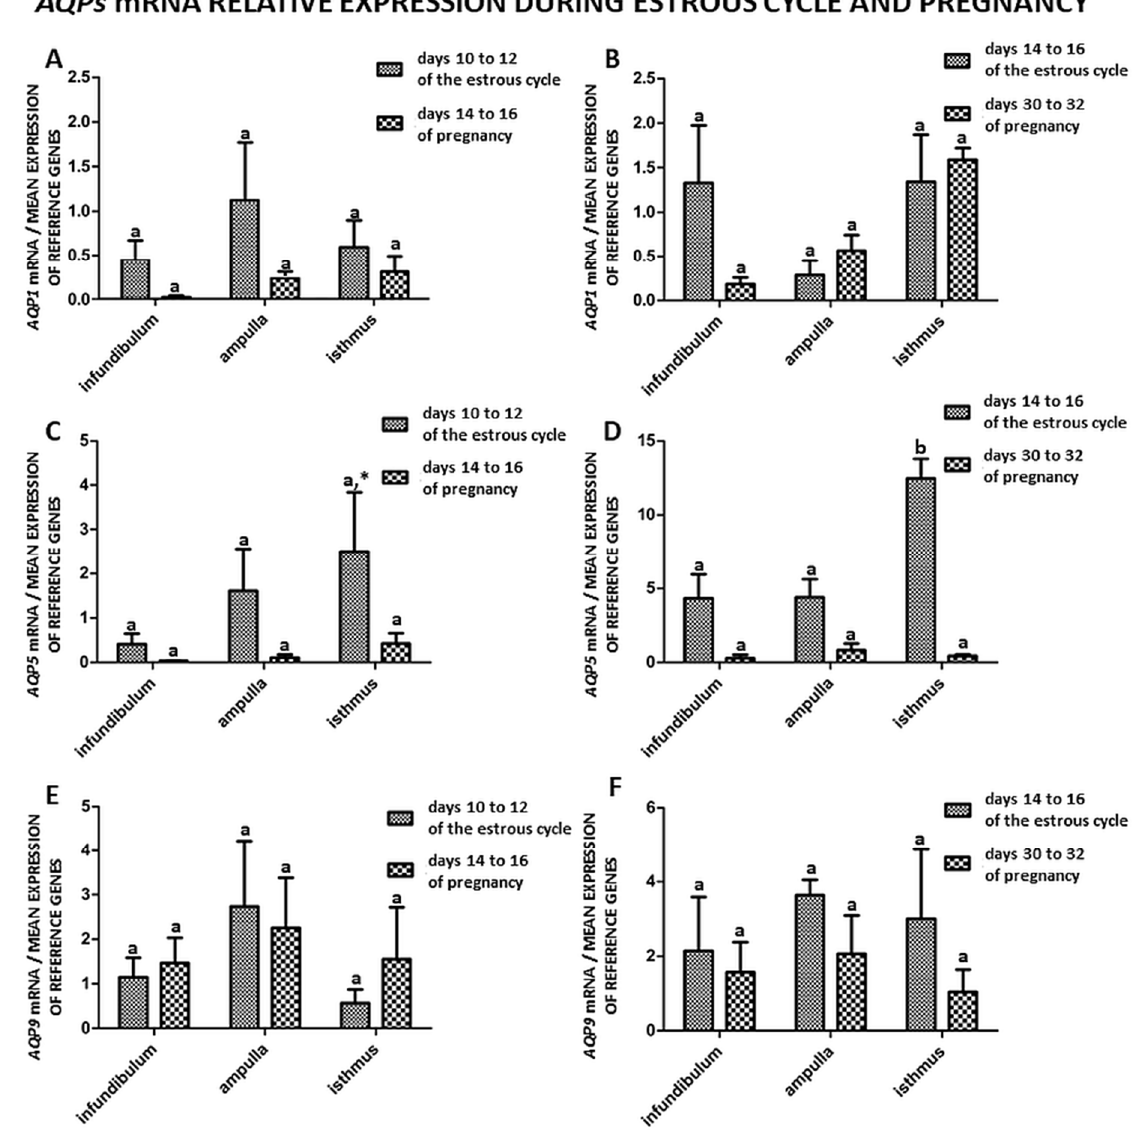
Figure 3. Comparison of the expression patterns of AQP1, 5, 9 genes in porcine oviduct separated into infundibulum, ampulla and isthmus from the estrus cycle (days 10–12 and 14–16) and early pregnancy (days 14–16 and 30–32). ( A , C , E ) summarized comparison between medium luteal phase (days 10–12) and pregnancy (days 14-16). ( B , D , F ) summarized comparison between late luteal phase (days 14–16) and pregnancy (days 30–32). The samples were subjected to qPCR analysis and normalized to the geometric mean of 18S RNA and PPIA expression. Each of the graphs marked with a capital letter indicates a specific part of the oviduct. Values are expressed as means ± S.E.M from five individuals, each performed in triplicate ( p < 0.05) ( n = 5). Statistically significant differences between the part of the oviduct from the estrous cycle and early pregnancy are indicated by different letters (a, b) and trends ( p < 0.1) by